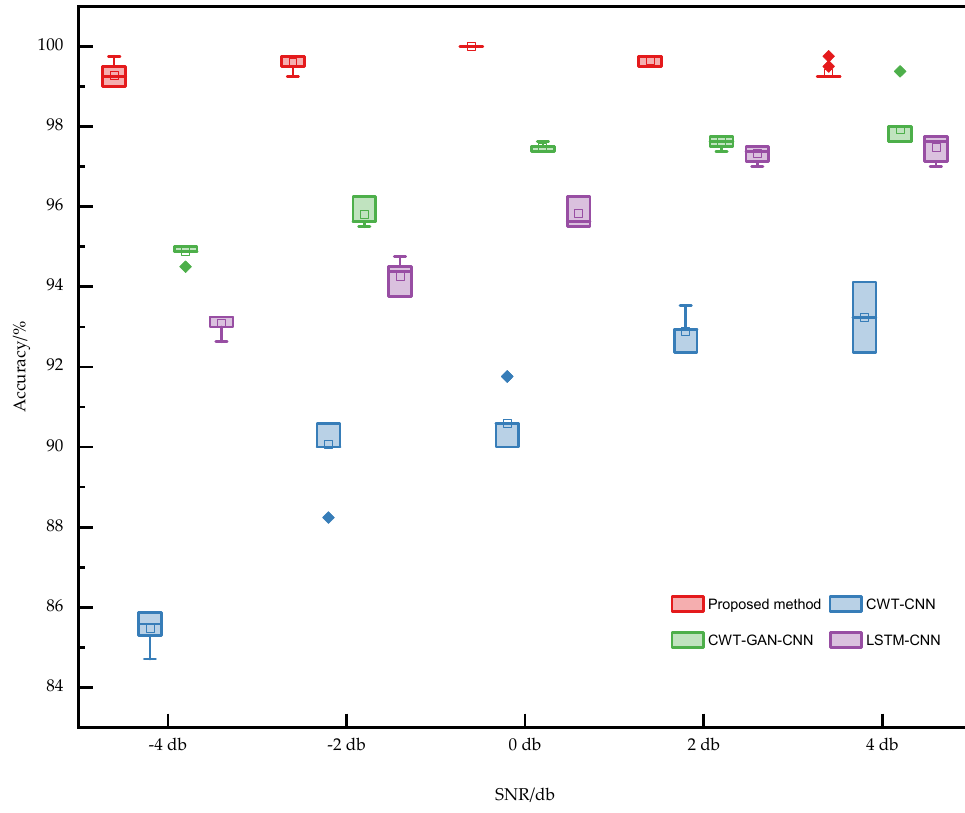
Figure 14. Comparison of the performance of different models with different SNRs. It mainly contains four models, including the proposed method, CWT − CNN, CWT − GAN − CNN, and LSTM − CNN. Table 4. Experiments for selection of optimal parameters using Dataset3.